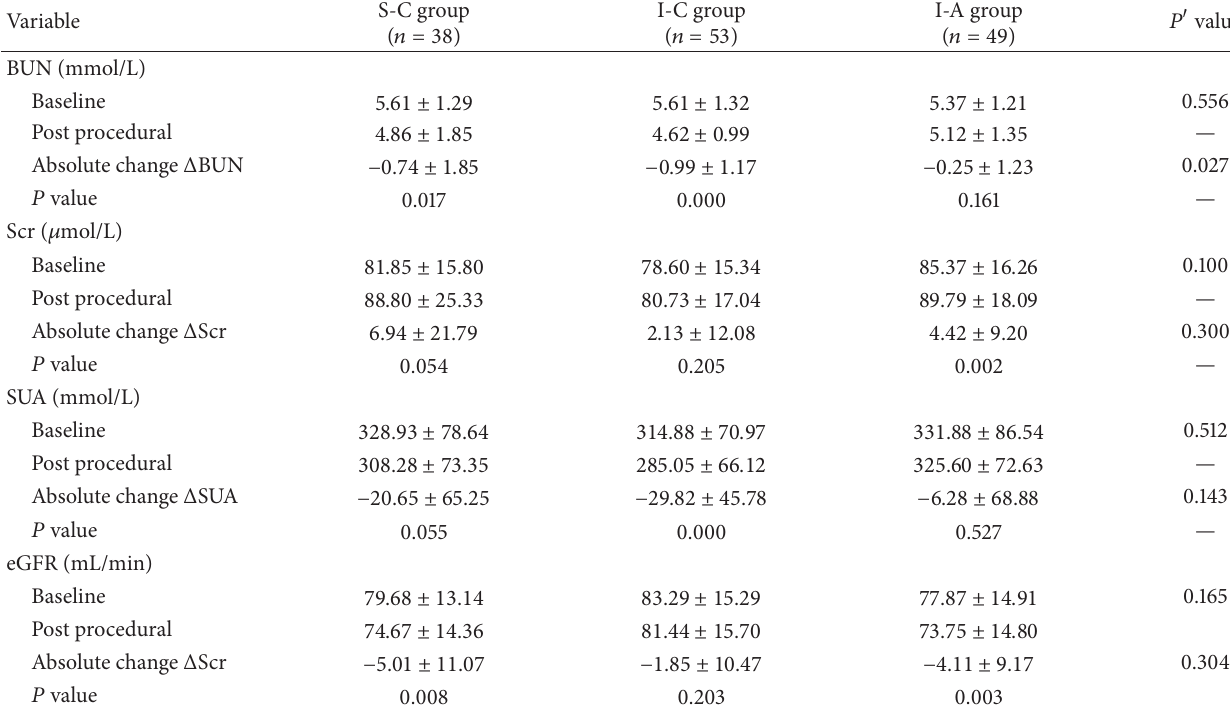
Table 3: Post-operation changes of renal parameters in the hypertensive